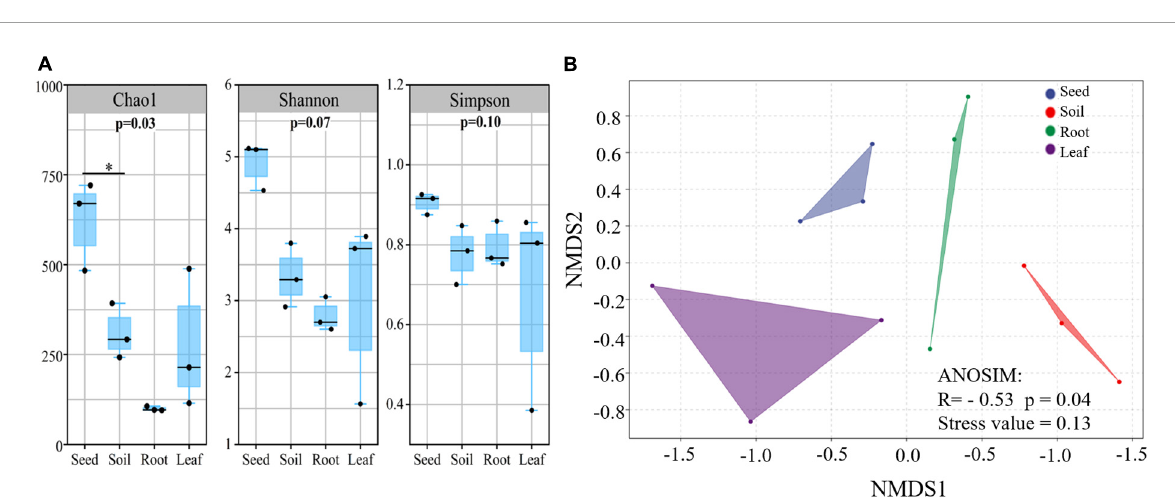
trivial levels of NO 2 − -N and NO 3 − -N were constituted in the coir medium. In contrast, in pots with seedlings, IEM- adsorbed NO 2 − and NO 3 − levels increased as the seedling grew, indicating nitrification was occurring. As the medium